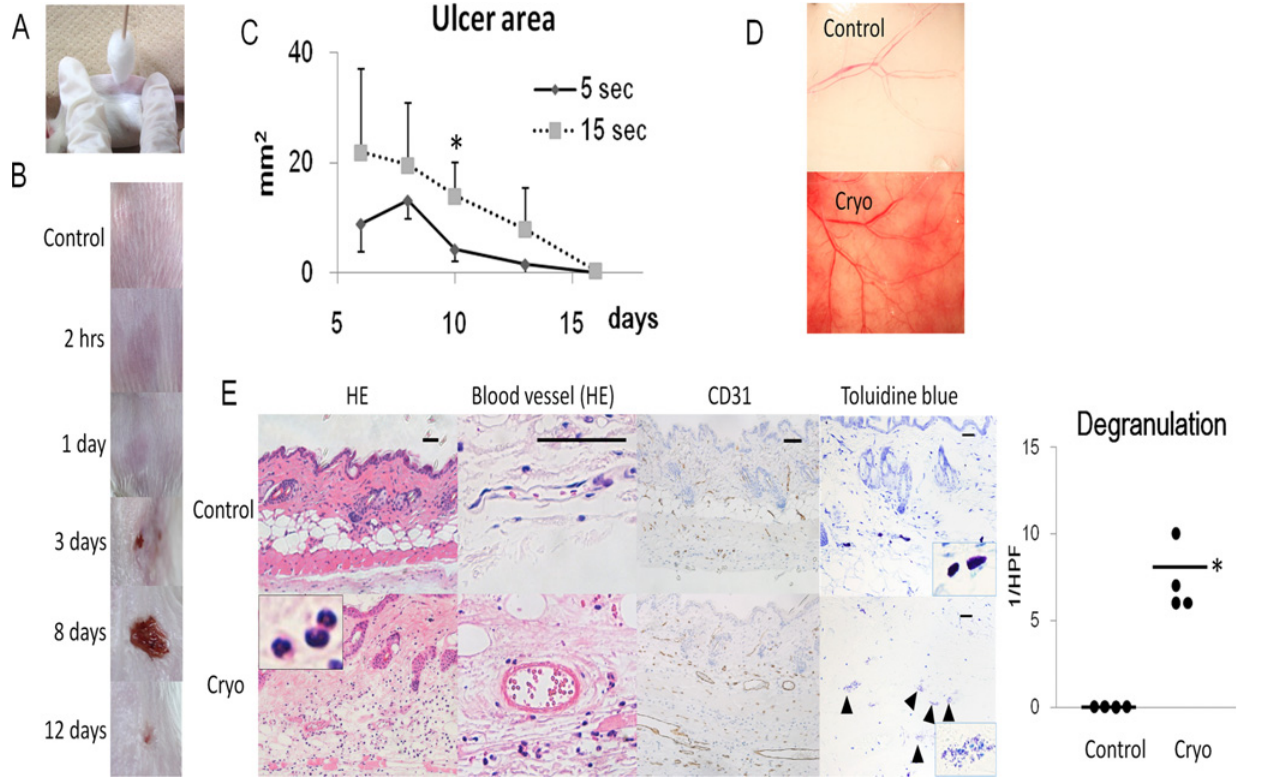
Fig 1. Cryoablation mouse model. A) Cryoablation technique using cotton swab. B) Macroscopic changes of the back after 15-sec cryoablation. C) Chronological changes of ulcer size of the back skin. The formed ulcer is larger in the 15-sec cryoablated group than in the 5-sec ablated group. D) Macrosopical changes of subcutaneous blood vessels in the 15-sec cryoablated group at day 1. E) HE stain, CD31 immunostaining (blood vessel marker), and truidine blue staining of the 15-sec cryoablated skin at day 1. Square box in HE stain shows a high power image of infiltrating cells, mainly neutrophils. The number of degranuated cells is also presented. Square box in toluidine blue stain shows high power image of degranuated mast cells ( ▲ ; arrowhead). All scale bars, 20 μ m. Cryo; cryoablation. sec; seconds. HPF; high power field. Values represent the mean ± SEM (C). Data are shown as dots (E). Bars represent the mean values. Significant differences between sample means are indicated, * P < 0.05 versus 5 sec in (C) and control in (E). n = 4, in each group.